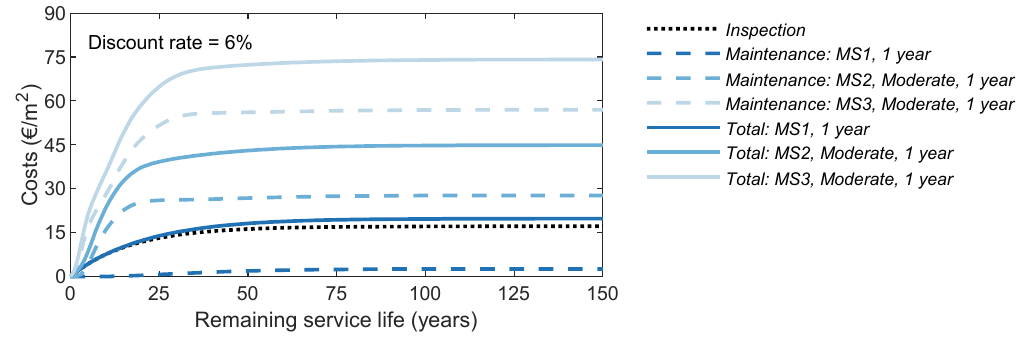
Figure 4. Cumulative costs (inspection, maintenance and total) profiles of the three maintenance strategies.